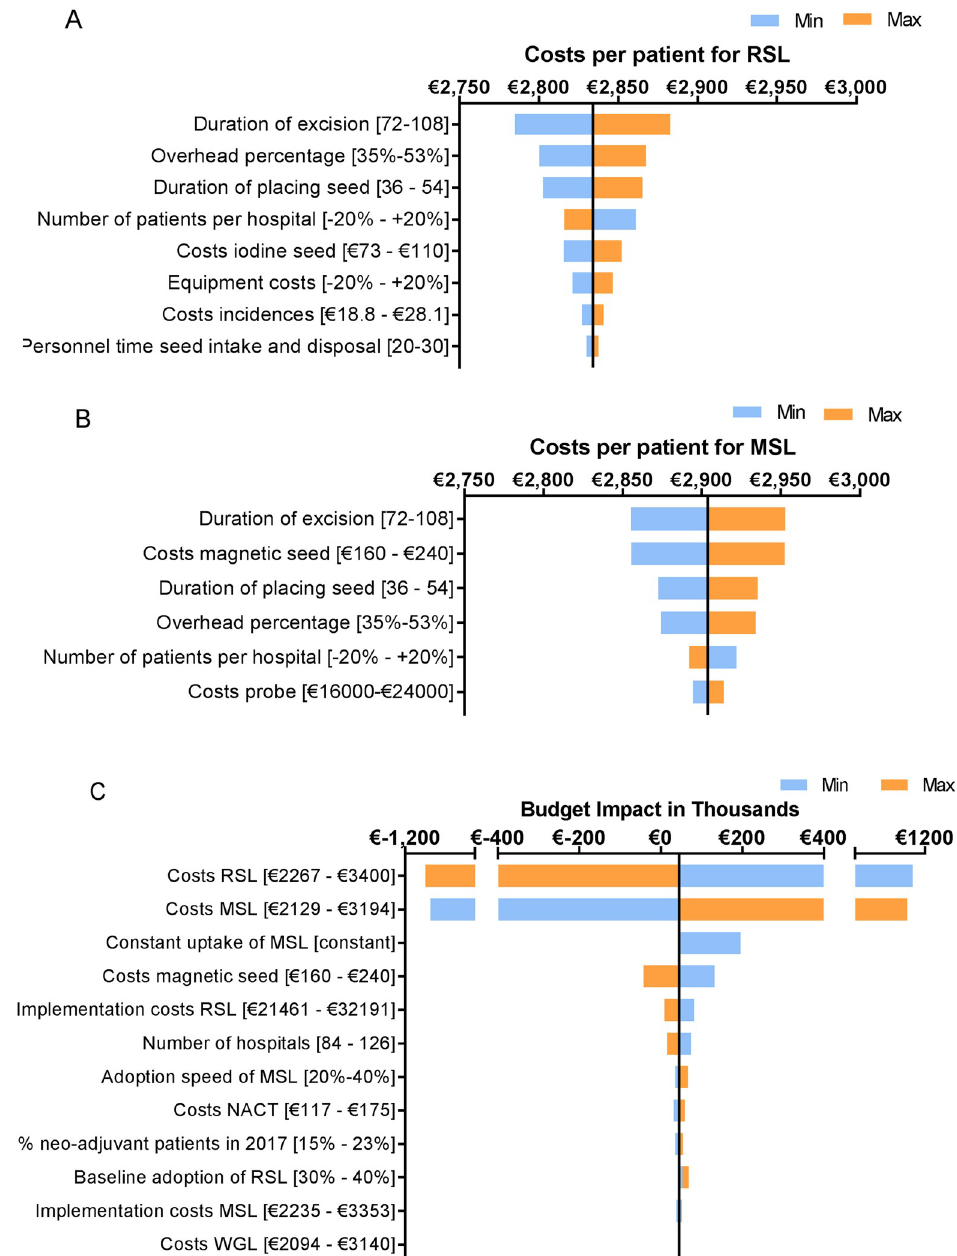
Fig 4. Results of the one-way sensitivity analyses. A. shows the results of the sensitivity analysis on the cost analysis results for RSL. The base case value is: 2,833.95. B. shows the results of the sensitivity analysis on the cost analysis results for MSL. The base case value is: 2,904.06 with a magnetic seed price of € 200. C. shows the results of the sensitivity analysis on the results of the budget impact analysis in 2022, with a magnetic seed price of € 200. The base case value is € 45,00. Explanation regarding parameter “constant uptake of MSL”: The yearly uptake of WGL was hold constant and the uptake of RSL was linked to the uptake of MSL (RSL yearly uptake = 100%—%MSL—%WGL). Abbreviations: WGL = wire-guided localization, RSL = radioactive seed localization, MSL = magnetic seed localization.